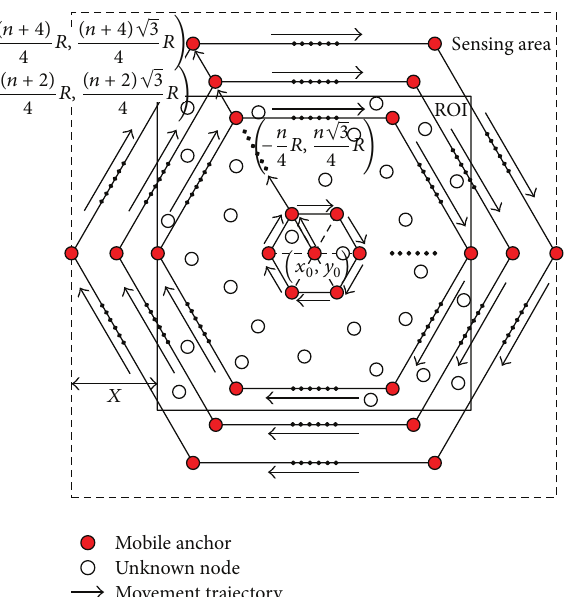
Figure 6: The relation of sensing area and ROI.